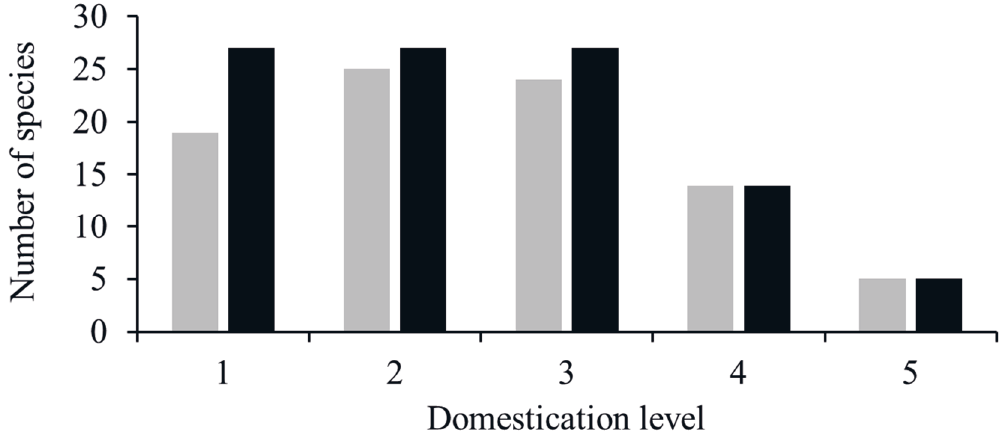
Figure 5. Domestication level of marine fish species in 2009 ( grey ) and 2013 ( black ).